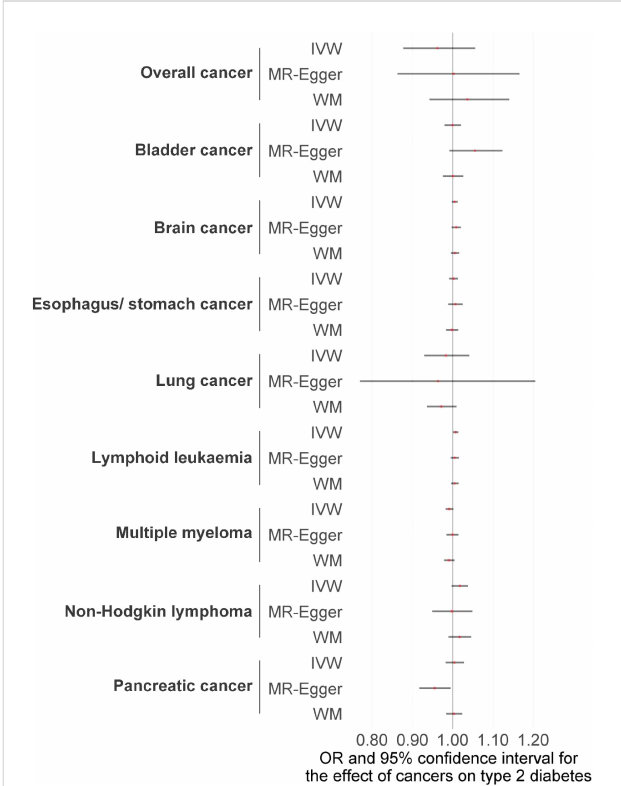
FIGURE 1 The potential causal relationships between site-speci fi c cancer and diabetes risk were examined using various MR methods, including IVW, MR-Egger, and WM. IVW, inverse-variance weighted method; MR, Mendelian randomization; WM, weighted median method; OR, odds